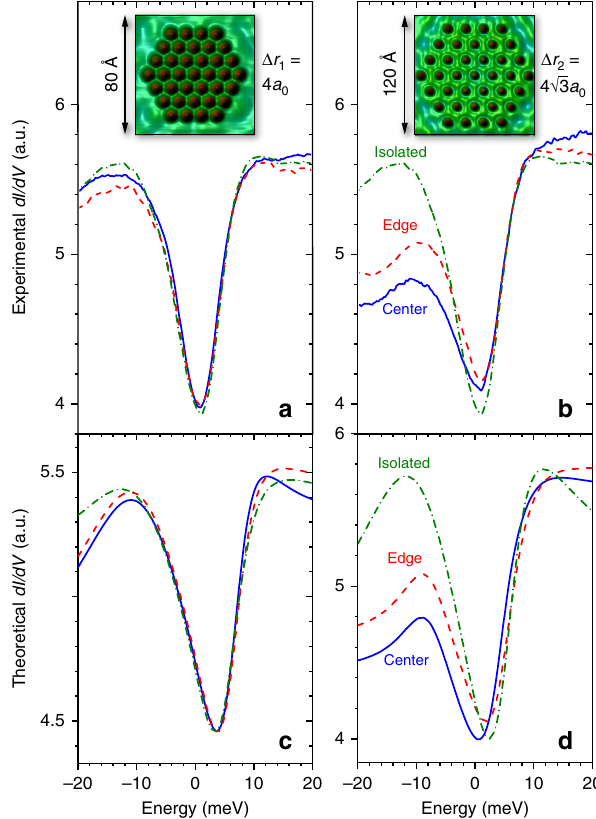
ffiffiffi p a (cid:4) 17 : 7 Å 3 0